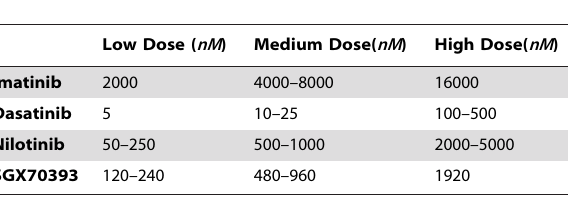
Table 1. Categorization of the doses of each